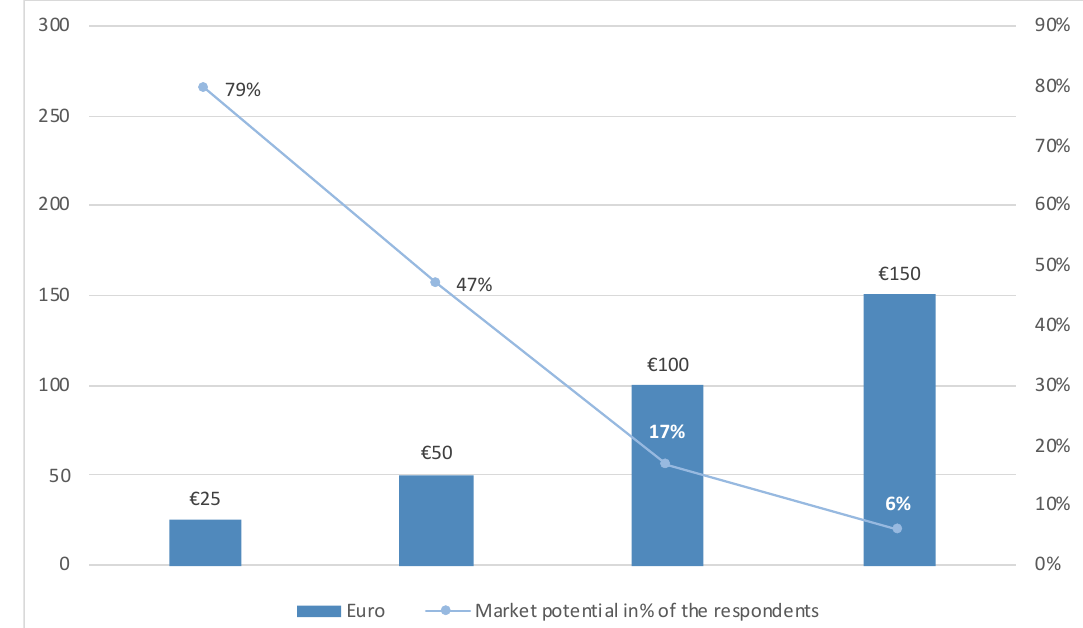
Figure 2. Indirect willingness to pay (WTP) for attribute levels of Mobility-as-a-Service (MaaS) packages (relative to default).